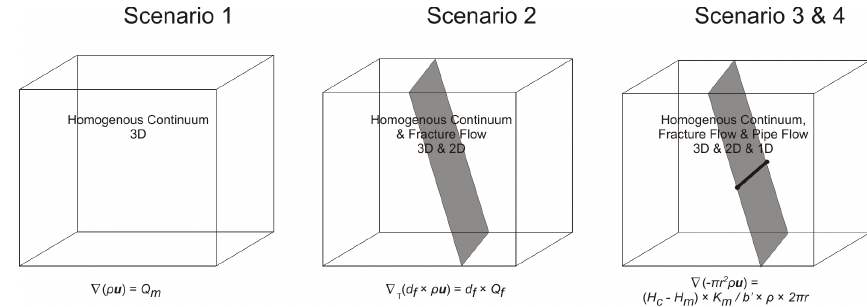
Fig. 1. Conceptual geometry of the simulated scenarios. For explanation of the flow equations see scenario description in Sect. 2.